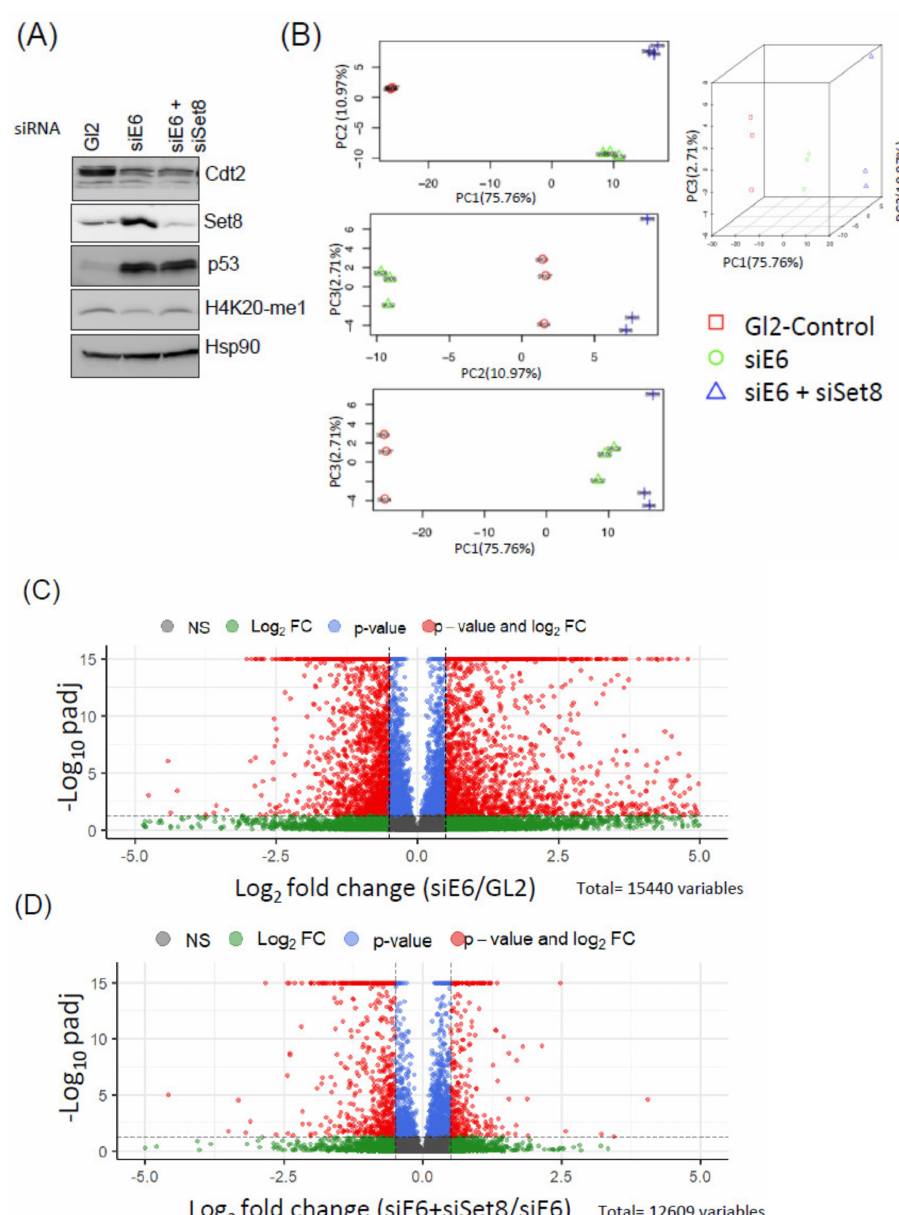
Figure 2. ( A ) Immunoblotting of indicated proteins after siE6 or siE6+siSet8. ( B ) Principal component analysis of the RNA seq results which show that the RNA seq from the knockdown conditions are reproducible and cluster as expected. ( C , D ) Volcano plots with Log2 fold change ( X -axis) vs. − Log10 p -value ( Y -axis) show that many genes are significantly up or down-regulated when E6 is knocked down ( C ) or when Set8 is co-knocked down with E6, relative to E6 alone ( D ). Red dots: genes with Log2FC > |0.5| and − Log10 adjusted p -value> 1.3. Genes with a − Log10 p -value > 15 were